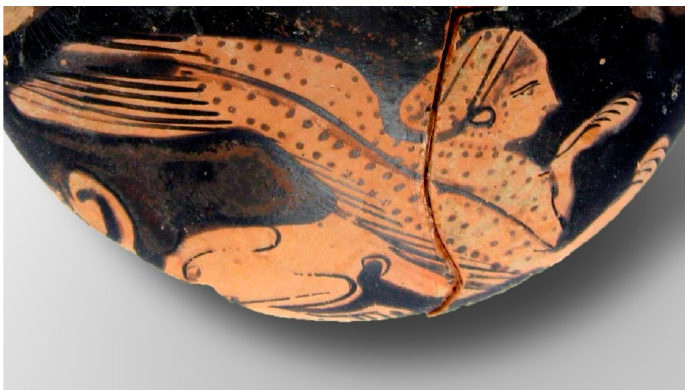
Figure 3. Winged reclining female sphinx wearing a cloth headdress ( sakkos ) (MGW inv. no. 2320); red-figure libation vessel ( guttus ); ca. late 5th century BCE .